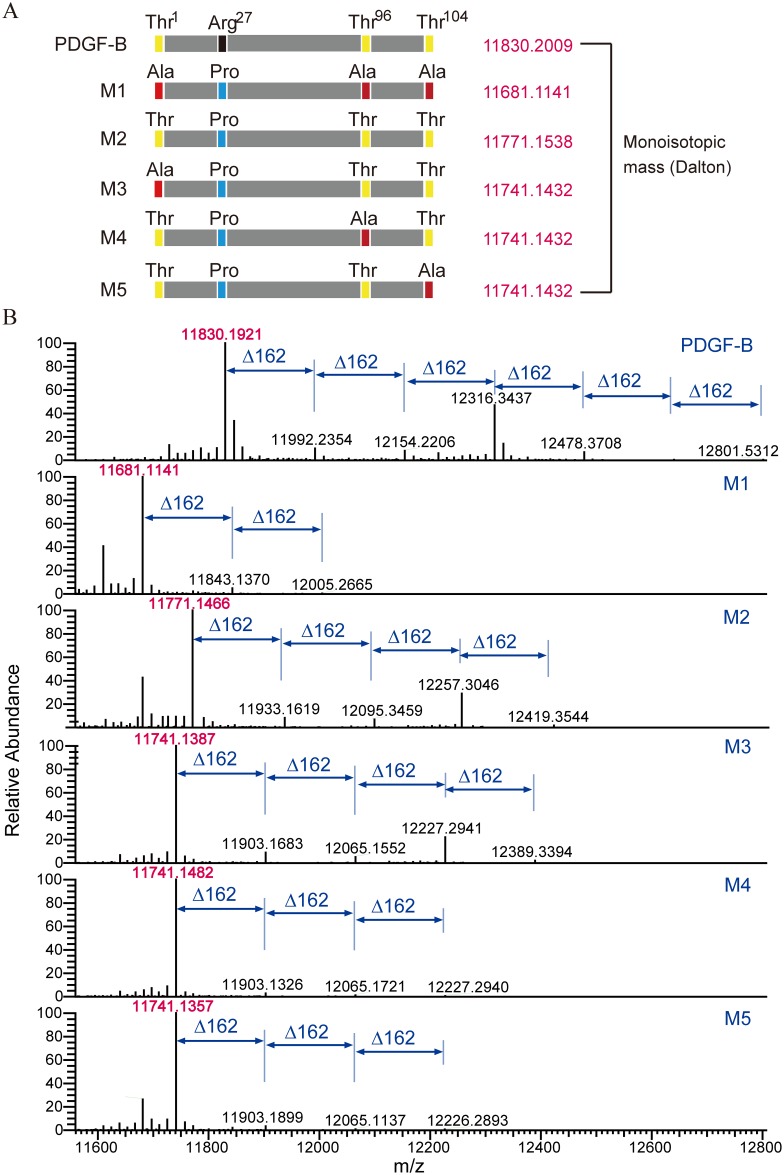
Identification of O-glycosylation sites in rhPDGF-BB using LC/MS.(A) Schematic representation of PDGF-B mutants. Monoisotopic mass of every mutant is shown. (B) Deconvoluted mass spectra of the wild-type PDGF and its mutants are presented with monoisotopic peaks; glycosylated isoforms are annotated.